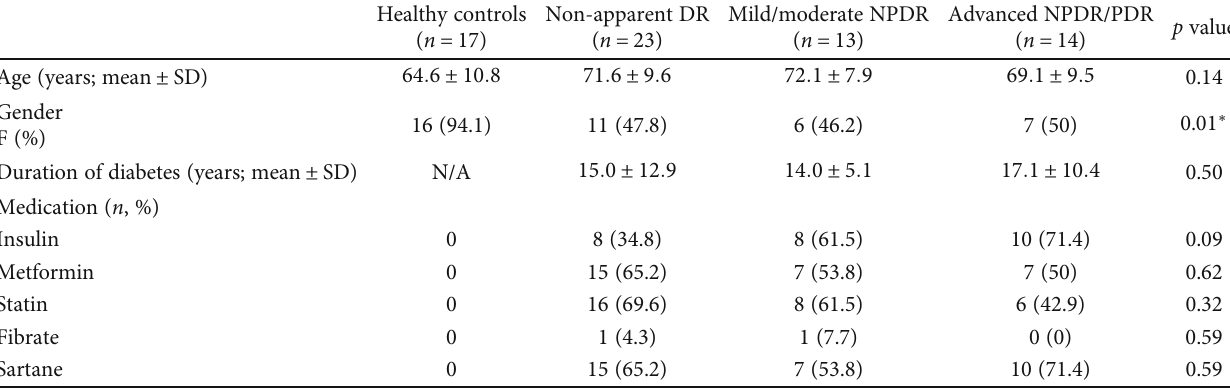
Table 1: Patient baseline characteristics.